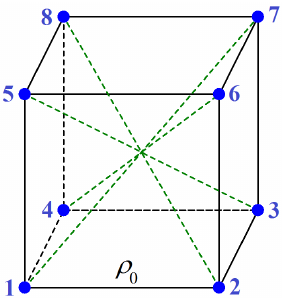
Figure 1. Cubene molecule model. Each vertex of a cube with side ρ 0 contains a carbon atom. Numbering of atoms in a cubene is shown. It is assumed that each carbon atom interacts through covalent bonds with the three nearest atoms and with the farthest atom; for example, atom 1 interacts with the atoms 2, 4, 5 and 7. Covalent bonds are described by the harmonic potential of stiffness K √ and equilibrium length ρ 0 for the nearest neighbors and 3 ρ 0 for the farthest